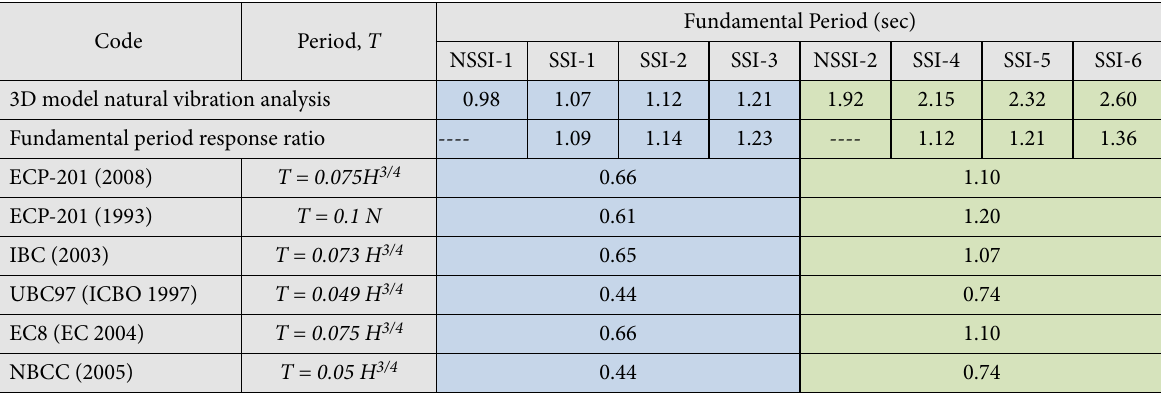
Table 4. Fundamental period of the RC moment resisting frame building